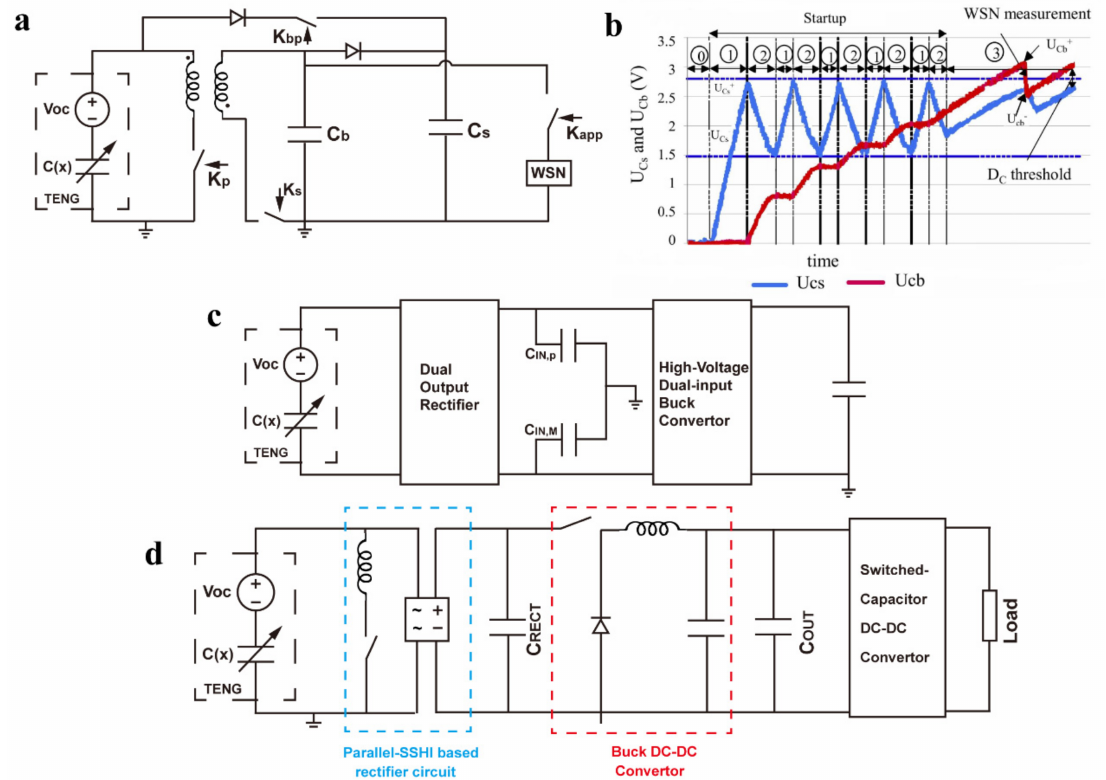
Figure 10. Power management with integrated circuit. ( a ) A self-starting power management integrated circuit for triboelectric energy harvesting. ( b ) Voltage waveform of capacitor C b and C s [79]. ( c ) A high-voltage dual-input integrated circuit converter for power management [80]. ( d ) A triboelectric energy harvesting circuit based on synchronous inductor parallel switch and DC step-down conversion